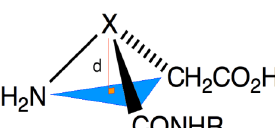
Figure 5. Measuring distortion from planarity in X-ray structure.